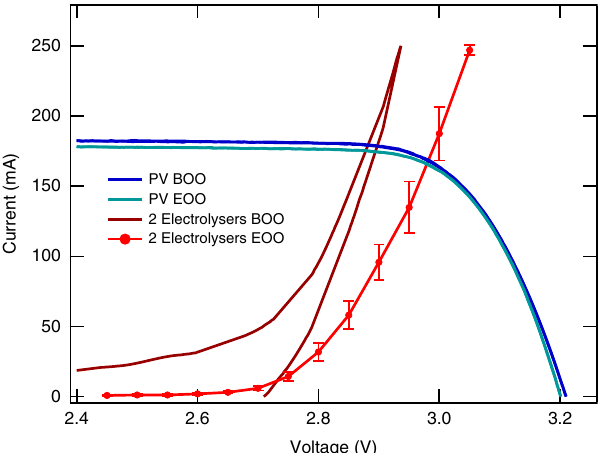
Figure 3 | PV cell and PEM electrolyser performance at the beginning and end of operation. The I – V characteristics of the triple-junction solar cell and the dual-electrolyser at both beginning-of-operation (BOO) and end-of- operation (EOO). The blue and cyan curves are the solar cell I – V curves under 42suns at BOO and EOO, respectively. The dark and light red curves are the I – V curves of the dual-electrolysers at BOO and EOO, respectively. The BOO electrolyser I – V was measured as a single cyclic voltammogram to minimize catalyst degradation before system operation. The EOO electrolyser I – V is presented as the average current for 2min holds at each potential, shown with error bars indicating 1 s.d. and a connecting line to guide the eye.